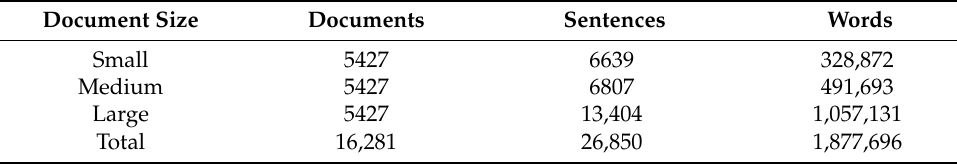
Table 3. Statistical descriptions of text examples used for